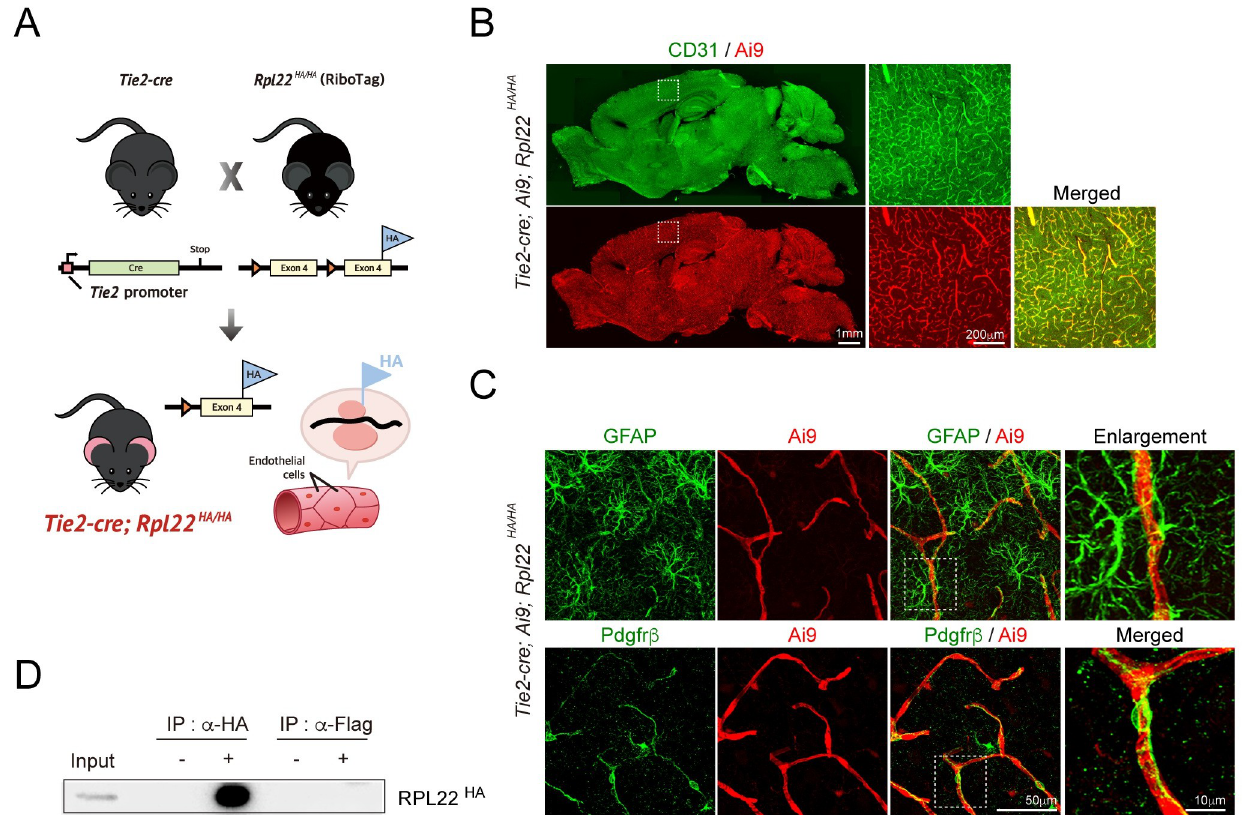
Fig 1. Validation of RiboTag mice for BEC-specific translatome analysis. (A) Tie2-Cre; Rpl22 HA/HA ( Ribo-Tag) mice, which are designed for expressing HA-tagged ribosomal protein in BECs. (B) Immunohistochemistry for Ai9 (Cre reporter, Red) and CD31 (endothelial cell marker, Green) in adult Tie2-Cre; Ai9; Rpl22 HA/HA mice. The regions in the dotted boxes in the left images are shown on the right at higher resolution. Scale bars, 1 mm (200 μ m in the insets). (C) Immunohistochemical staining for Gfap and Ai9 (left column) and for Pdgfrb and Ai9 (right column) in the cortex of adult Tie2-Cre; Ai9; Rpl22 HA/HA mice. Gfap + astrocytes and Pdgfr+ pericytes did not overlap with Cre recombinase, as represented by the Ai9 reporter gene. (D) Immunoprecipitation of the HA-tagged ribosomal protein RPL22HA, which is a component of actively translating polyribosomes. The expression of HA- tagged RPL22A was investigated by immunoprecipitation with mouse IgG (-) or anti-HA (+) or with anti-Flag (+) and subsequent Western blotting with anti-HA.